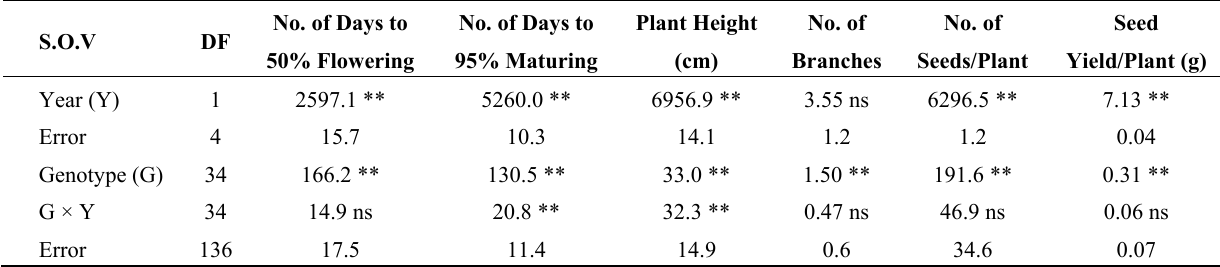
Table 2. Combined mean squares estimates for studied traits. S.O.V (source of variation); DF (Degrees of Freedom); No. (Number). S.O.V